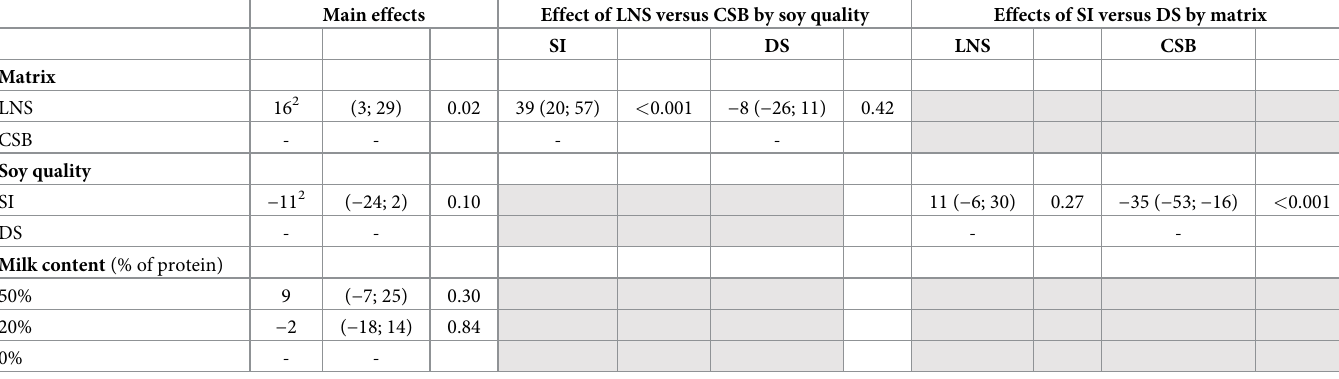
Table 6. Effects of matrix, soy quality, and milk content in supplementary foods on SC (pmol/L) at end of the 3 months supplementation among 1,016 children with MAM 1